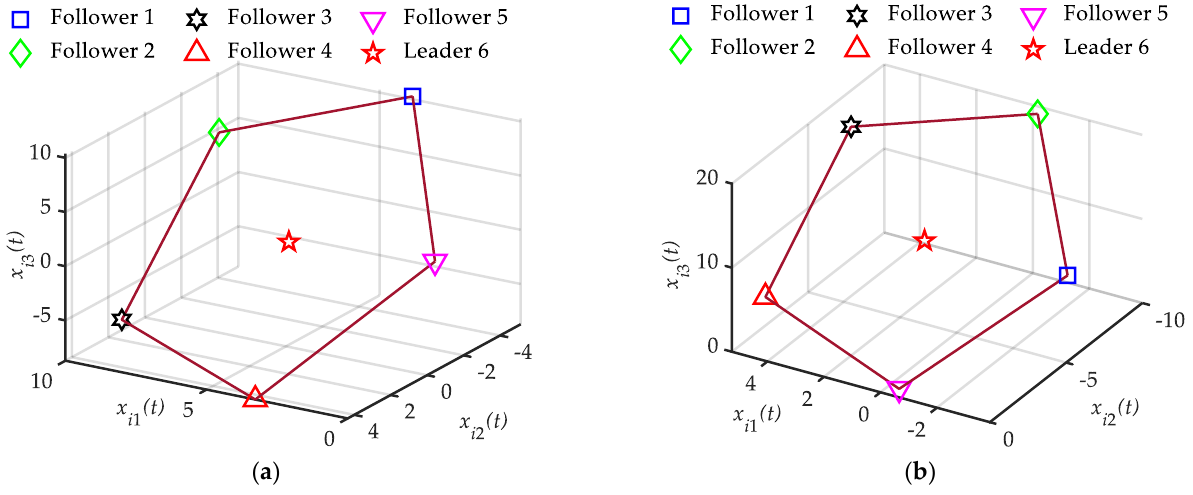
Figure 3. State snapshots of all the agents without external disturbances and the convex combination of five followers at different times. ( a ) t = 5 s ; ( b ) t = 10 s .